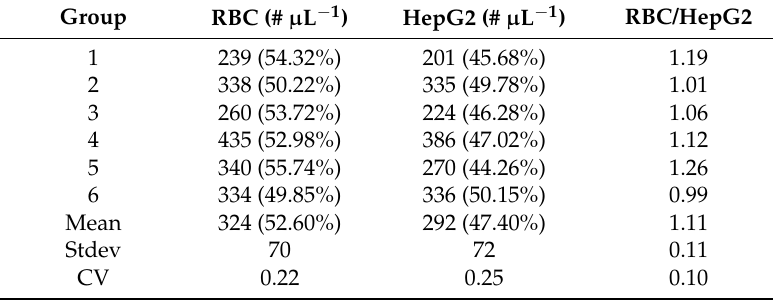
Table 4. Measured counting results of mixed Red blood cell (RBC) and HepG2